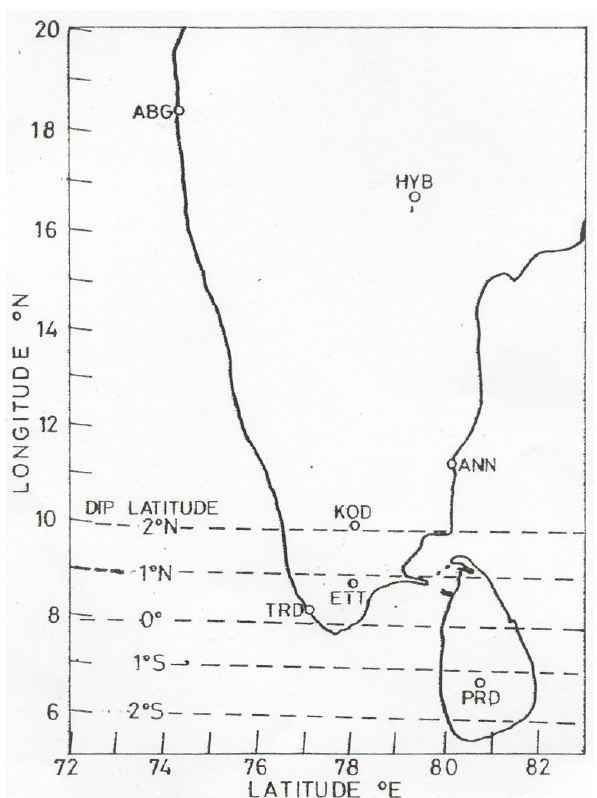
Fig. 2. The map showing the location of geomagnetic observatories and of the iso dip line of + 1, + 2 and 0degrees in the Indo-Sri Lanka longitude sector. Note that Peredinia is the only observatory in this sector situated south of the dip